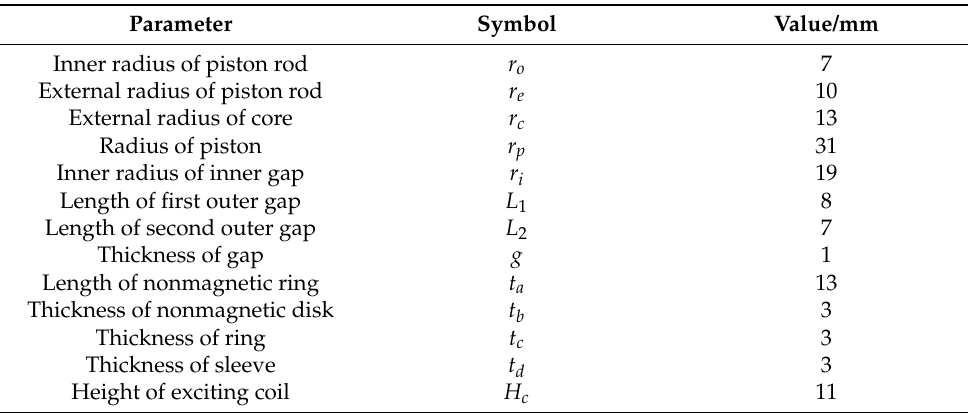
Figure 2. Piston assembly diagram of the MR damper. Table 1. Main structural dimensions of the proposed initial MR damper.